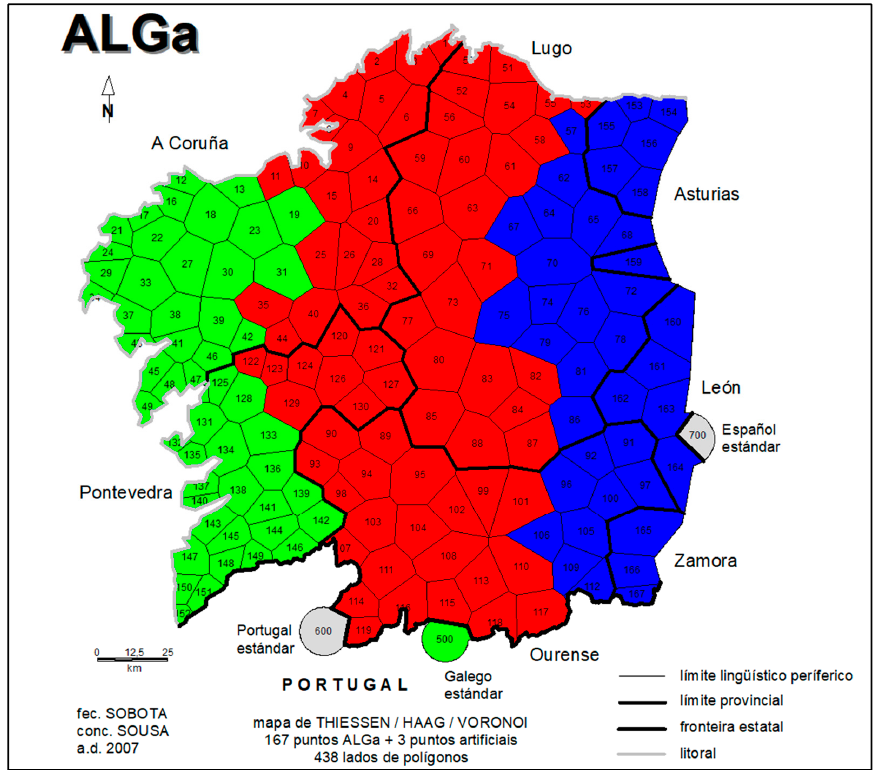
Figure 5. Cluster map: dendrographic classification of 168 dialectological points (324 morphosyntactic Figure5. Clustermap: features).